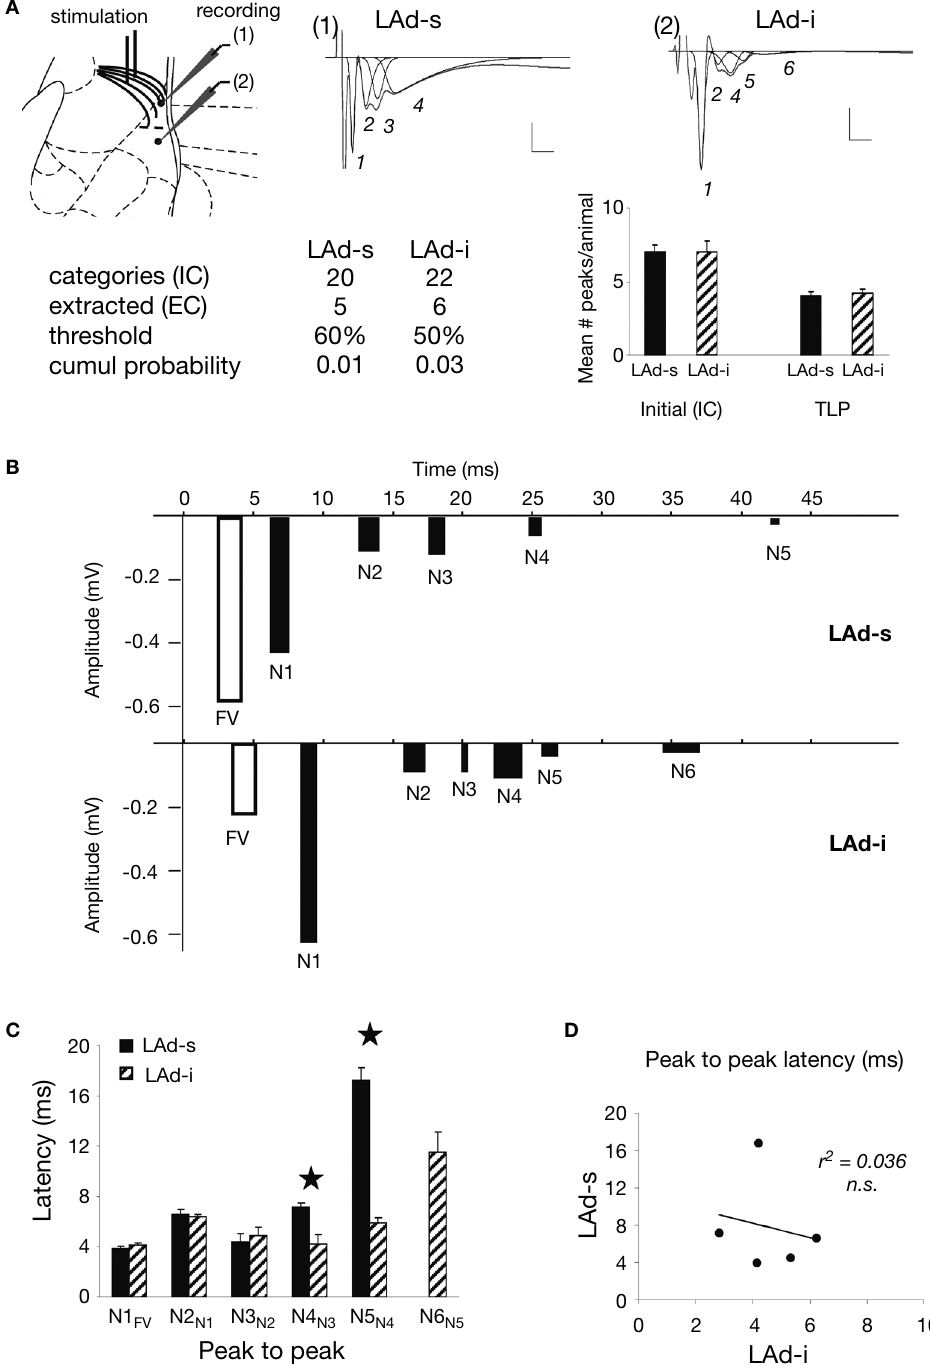
Figure 4 | Temporal organization of TLPs in the dorsal lateral amygdala. (A) Atlas image depicts the location of stimulating electrode in extra-LA thalamic afferents fi bers and two recording electrodes in the LAd-s and LAd-i. Example of FP traces from LAd-s (1, scale = 0.1 mV, 10 ms) and LAd-i (2, scale = 0.2 mV, 10 ms) depicting non-linear peak fi tting and TLPs determined probabilistically (see Materials and Methods). From the initial number of categories found (IC), probabilistic analysis (threshold defi ning the minimum number of occurrence across animals resulting in a cumulative probability < 0.05) extracted only few categories as reliably occurring between animals (EC). Averaged number of peaks per animal was reduced by approximately 50%, indicating that approximately 50% of all peaks detected using the non-linear curve fi tting method are temporally reliable across animals (TLP). LAd-s example has TLPs N1–N4, LAd-i exam- ple has N1–N6, but misses N3. (B) Latency ranges (widths of bars) of TLPs in LAd-s and LAd-i shown in “real time” from stimulation artifact. Latency to the FV tended to be increased in the LAd-i consistent with a bigger distance between stimulating and recording electrodes. Analysis of variance indicated that these peaks were not occurring at the same time as there was a signifi cant interaction between the two data sets F (5,54) = 80.18, p < 0.0001. Bonferroni post-hoc t -tests reveal N2 and N5 are signifi cantly different at p < 0.01. (C) Comparison of peak to peak latencies [e.g. N1FV means (N1 latency–FV latency)] between TLPs of LAd-s and LAd-i. The fi rst three TLPs arrive at similar latencies after their preceding ones at both recording sites. In comparison N4 and N5 occur later in the LAd-s compared to the LAd-i. * p < 0.05. (D) There was no correlation between peak to peak latencies in LAd-s and LAd-i, showing different rhythmic pattern in these two sub-areas of